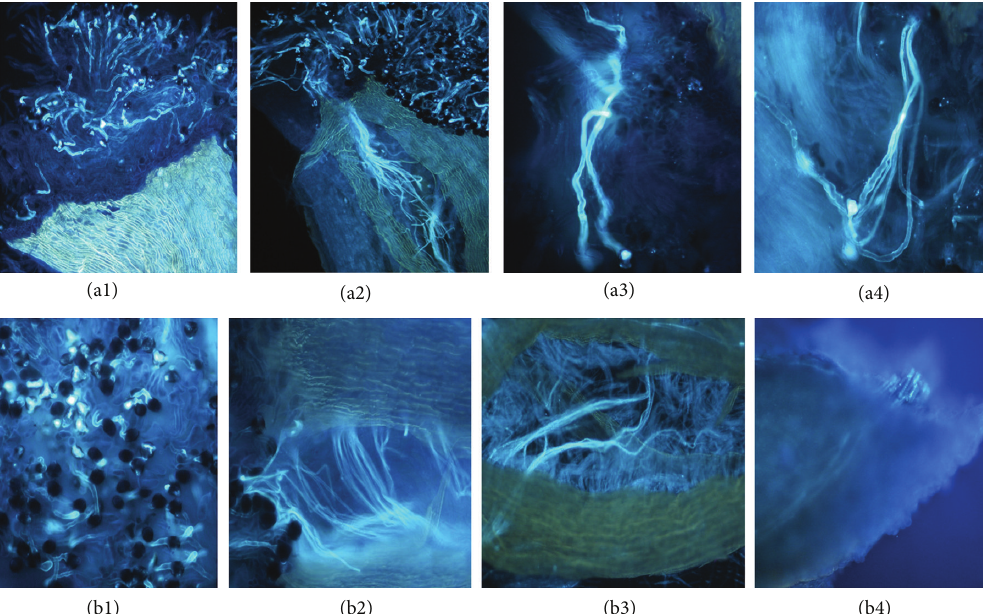
Figure 5: Fluorescence micrographs of squashed styles of “Hongpisu” harvested after different pollination treatments. (a1) Germination of pollen grains on stigma 2 h after self-pollination. (a2) Growth of pollen tubes in style transmitting tissue 6 h after self-pollination. (a3) Growth inhibition of pollen tubes in style transmitting tissue 8h after self-pollination. (a4) Twisted pollen tubes 12 h after self-pollination. (b1) Germination of pollen grains on stigma 1h after cross-pollination. (b2) Growth of pollen tubes in style transmitting tissue 8 h after cross- pollination. (b3) Growth of pollen tubes in style transmitting tissue 12h after cross-pollination. (b4) Pollen tubes arrive at the base of the style 24 h after cross-pollination.